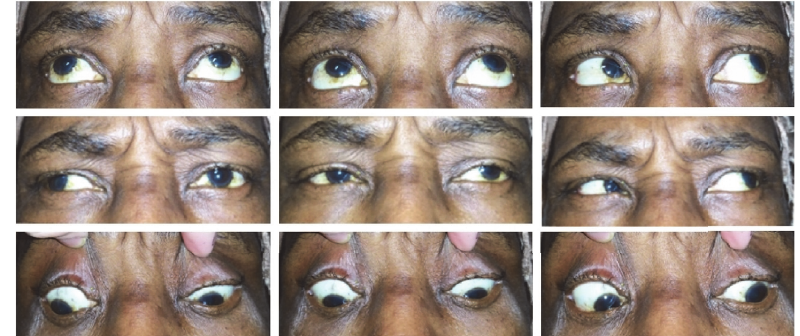
Figure 1: Left INO with absent left eye adduction. Exotropia and left skew deviation are present.